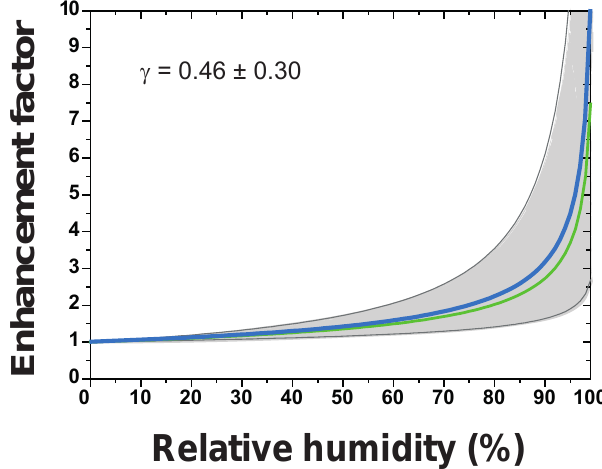
Figure 6. Mean value of the enhancement factor for the 550nm particle extinction coefficient (blue line; obtained with Eq. (3) for the mean value γ ). The upper and lower boundaries of the gray- shaded area are obtained by using γ + δγ (upper boundary) and γ − δγ (lower boundary) in Eq. (3). The given mean values and SD of the parameter γ result from the evaluation of 143 observational cases collected in the years 2009–2012. The green curve is shown for comparison and represents urban haze conditions according to Hänel (1984) with γ = 0 .